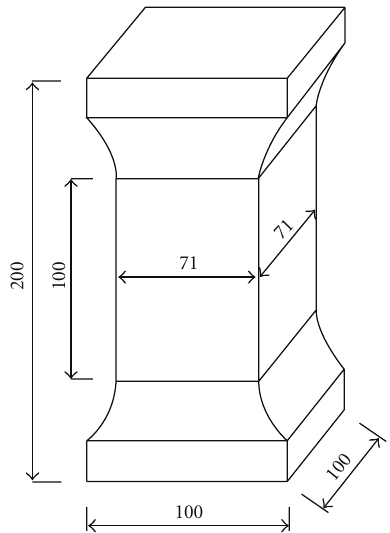
Figure 1: Dimensions of dumbbell-shaped specimen (unit: